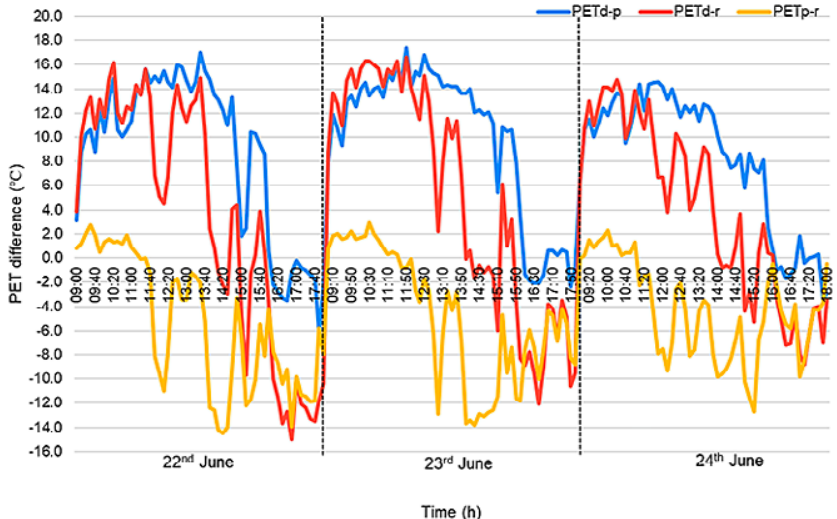
Figure 8. Temporal variation of PET in Banja Luka (Bosnia and Herzegovina) in the period 22-24 June 2021 (measurement period 9-18 h CEST). NOTE: PET represents Physiologically Equivalent Temperature difference between d-p downtown and urban park; PET represents Physiologically Equivalent Temperature difference between downtown and d-r riverside; and PET represents Physiologically Equivalent Temperature difference between urban park and p-r